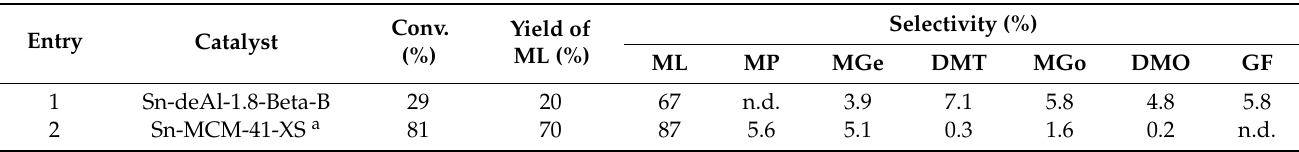
Table 4. Catalytic performance of Sn-Beta zeolite beads in combination with AuPd-NP/CNT-F in the conversion of glycerol to methyl lactate.